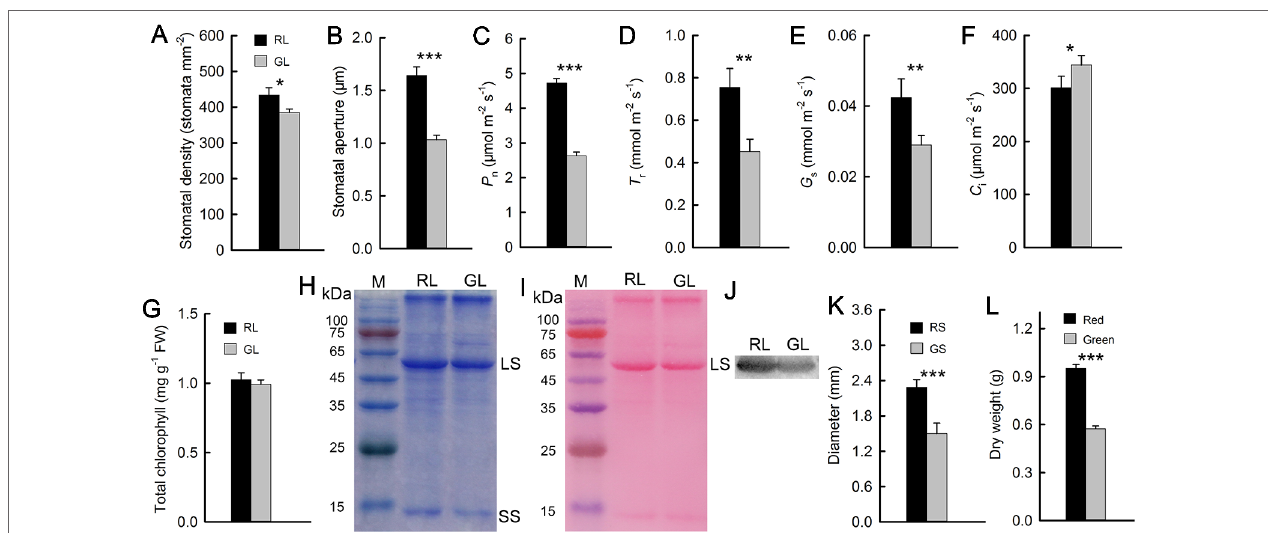
FIGURE 3 | Stomatal density and aperture of red (RL) and green leaves (GL) (A, B) . Gas exchange parameters of red and green leaves, including the net photosynthetic rate ( P n ) (C) , transpiration rate ( T r ) (D) , stomatal conductance ( G s ) (E) , and intercellular CO 2 concentration ( C i ) (F) (n = 10). Chlorophyll (Chl) content in RL and GL (G) (n = 8). Rubisco LS and small subunit (SS) were separated in 12.5% SDS-PAGE, and the polypeptides were stained by Coomassie Brilliant Blue R-250 (H) . The membrane of the Western blot was stained by Ponceau S (I) , and the Western blotting showed LS in RL and GL (J) . Diameter of red (RS) and green stems (GS) (K) (n = 15) and dry weight of red and green M. micrantha plants (L) (n = 8). The error bars represent the standard errors (SEs) of 8 to 15 biological replicates, and the asterisks indicate significant differences (two-sided Student’s t-test, * P < 0.05, ** P < 0.01, *** P <